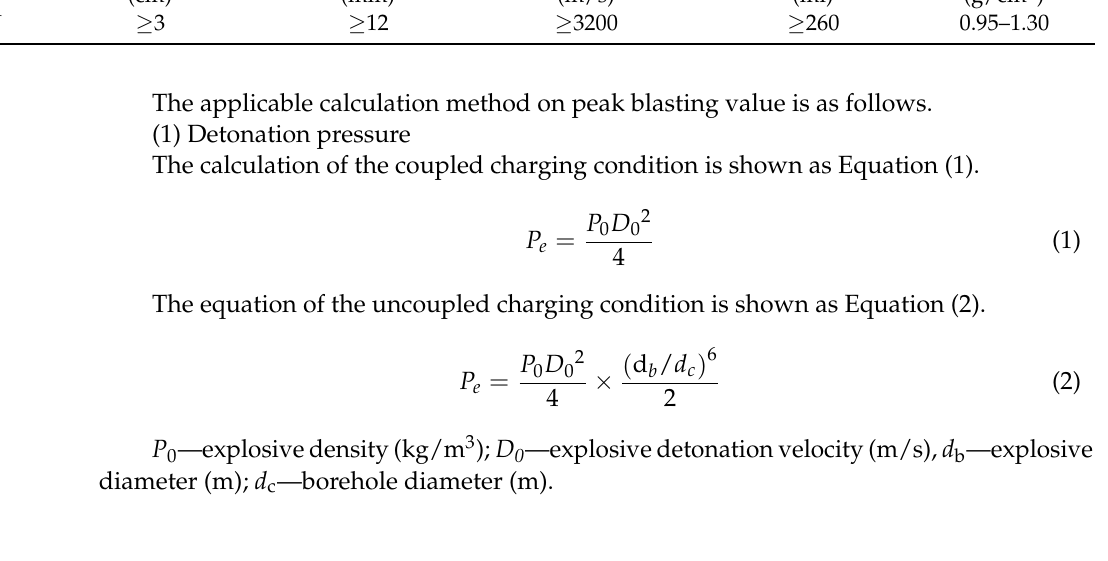
Figure 7. Retaining walls of the foundation pit. Table 2. The design parameters of the supporting structure.